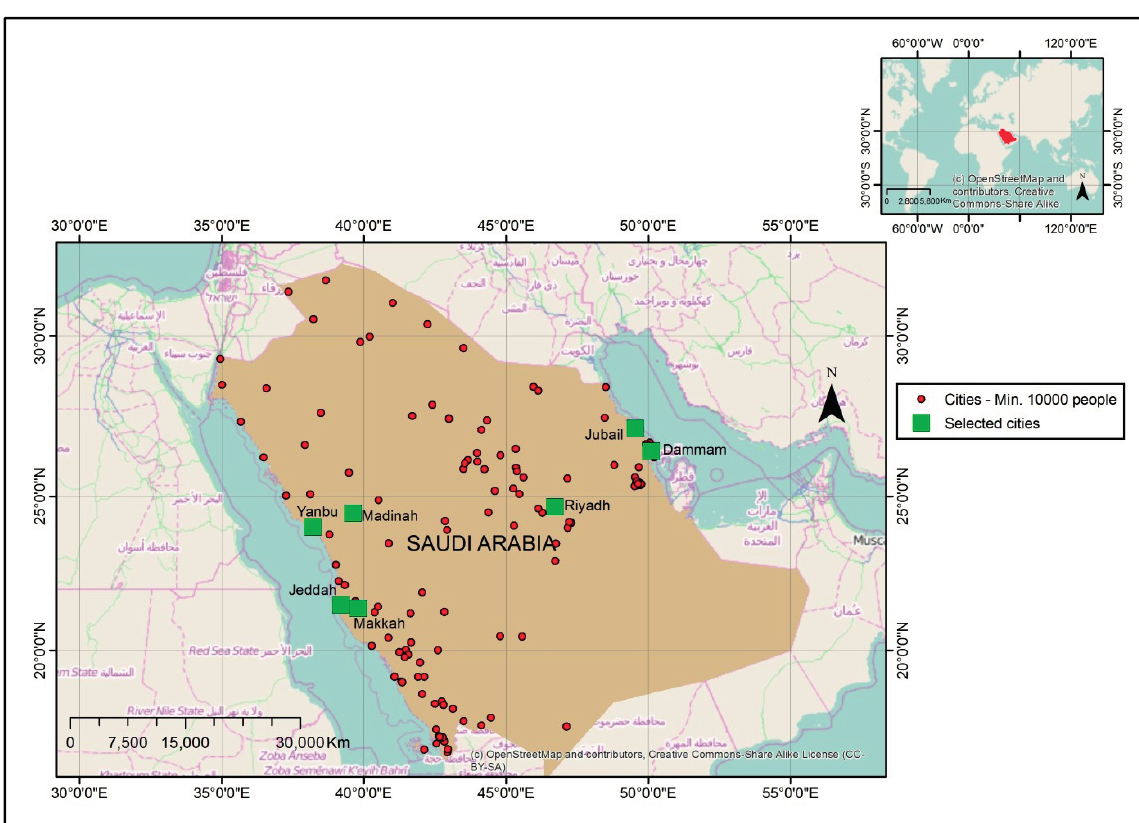
Figure 1. Location of selected